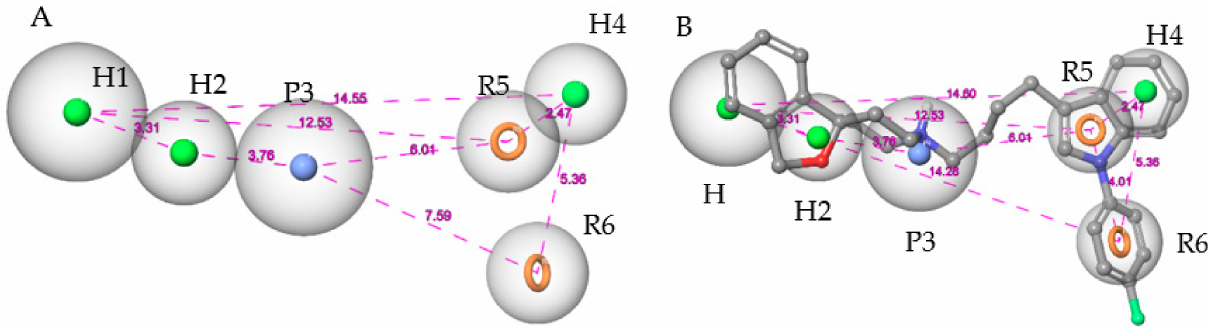
Figure 3. ( A ) The adjusted pharmacophore model. ( B ) Pharmacophore model with siramesine mapped inside. The spatial distances between the pharmacophoric elements are shown to emphasize the three-dimensionality of the pharma- cophore